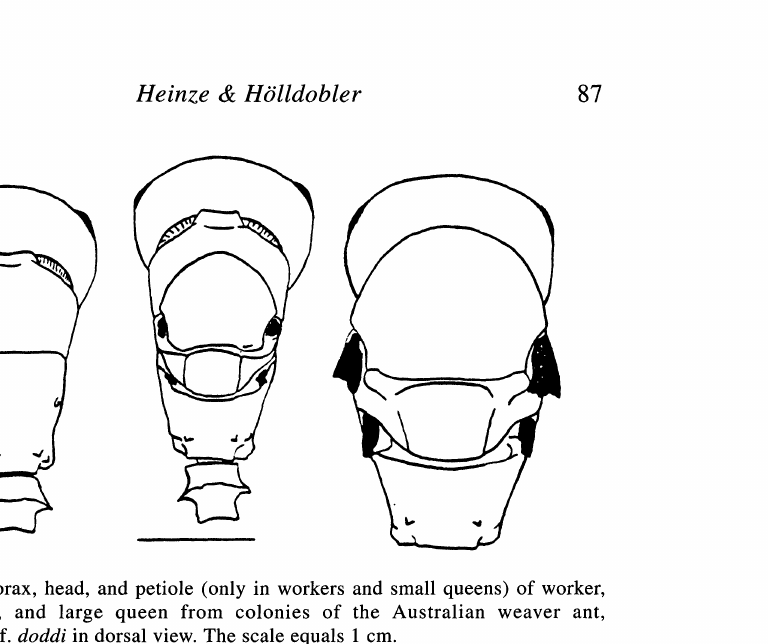
Fig. 3. Thorax, head, and petiole (only in workers and small queens) of worker, small queen, and large queen from colonies of the Australian weaver ant, Polyrhachis cf. doddi in dorsal view. The scale equals